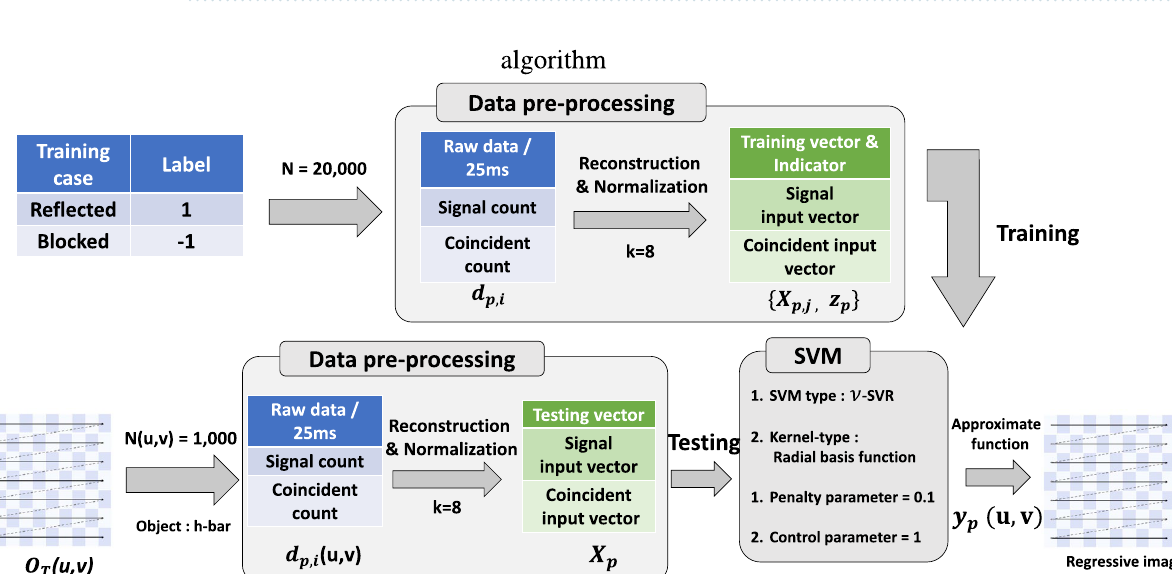
Figure 3. A schematic diagram of the PSSVM algorithm. The PSSVM works as a binary pattern classifier, requiring data of both ‘Reflected’ and ‘Blocked’ types. The training data is prepared as a k -dimensional input vector containing information of photon distribution through pre-processing. The trained PSSVM is applied to each of the 2500 pixels of the image to obtain an indicator vector y p ( u , v ) . In our study, the penalty parameter is C = 0.1 , the control parameter is ν = 1 , and the kernel function φ( · ) is the radial basis